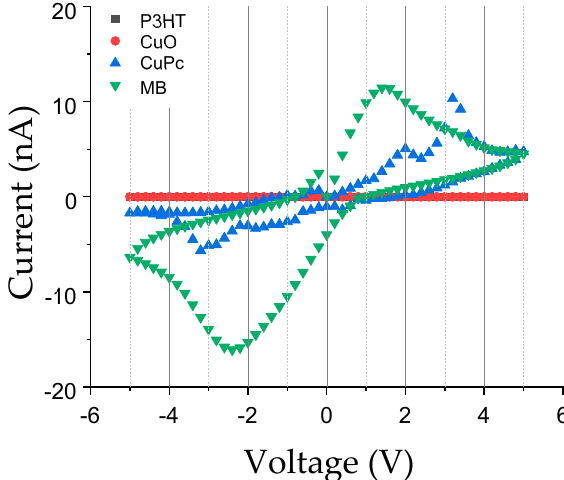
Figure 3. Quantitative evaluation of pure and composite PVDF-TrFE nanofibers’ fiber diameters via image analysis.